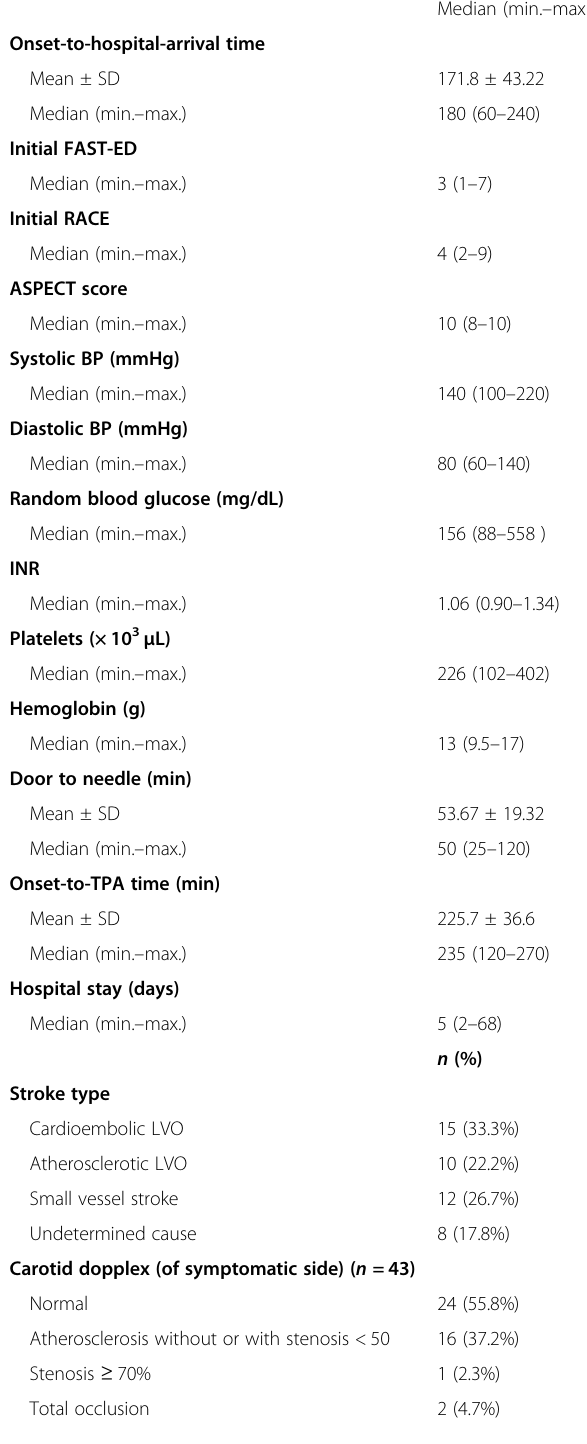
Table 2 Patient assessment and hospital factors pre- and Median (min. – max.)